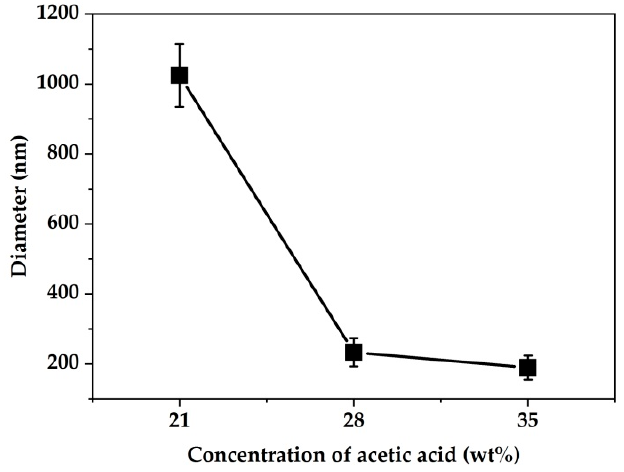
Figure 7. Average diameters of TiO 2 /ZnO nanofibers according to the amount of acetic acid.